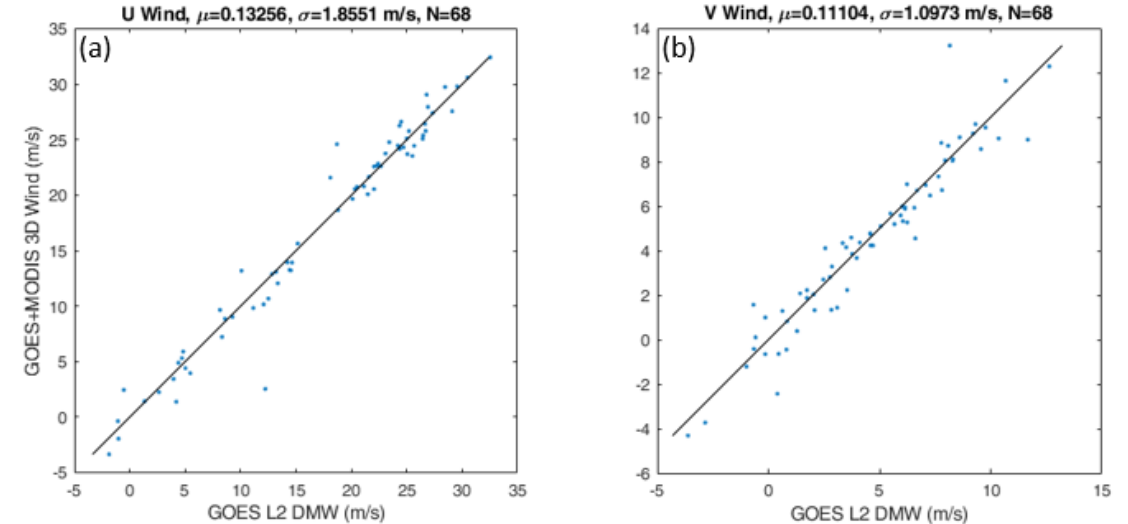
Figure 21. Retrieved MODIS-GOES winds are compared with the NOAA operational DMW product for an IR case along the U axis ( a ) and V axis ( b ). The diagonal line is the perfect match, and the statistics are computed over the retrieval differences (mean µ and standard deviation σ , over sample size N). The MODIS granule is MOD2019057.2000.061 and the DMW product is for ABI band 14 and the CONUS scene with product time 2019/057 20:02.